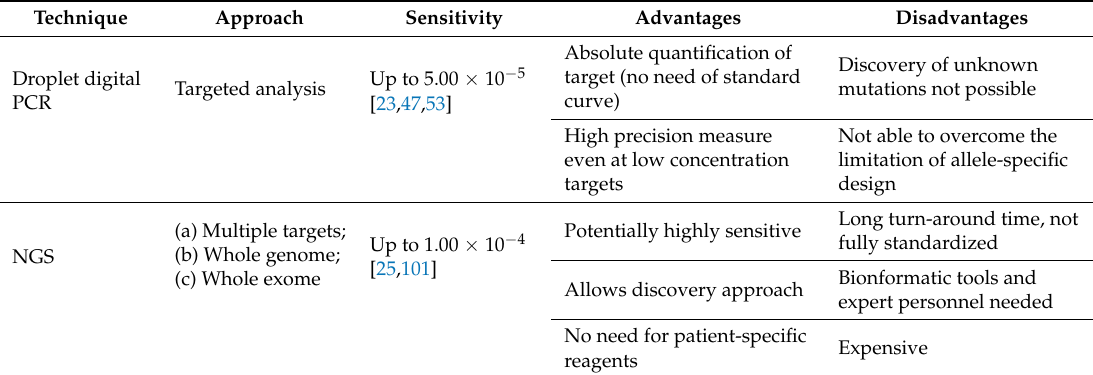
Table 1. Technical comparison of droplet dPCR and next generation sequencing (NGS) for MRD study in lymphoproliferative